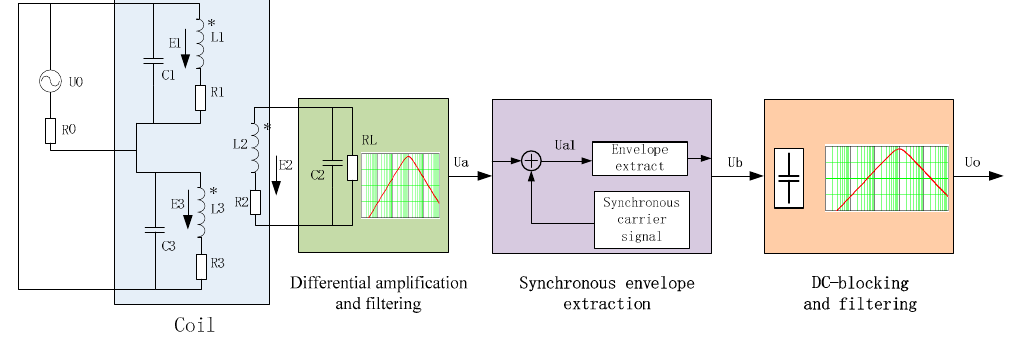
Figure 7. The detective circuit schematic.